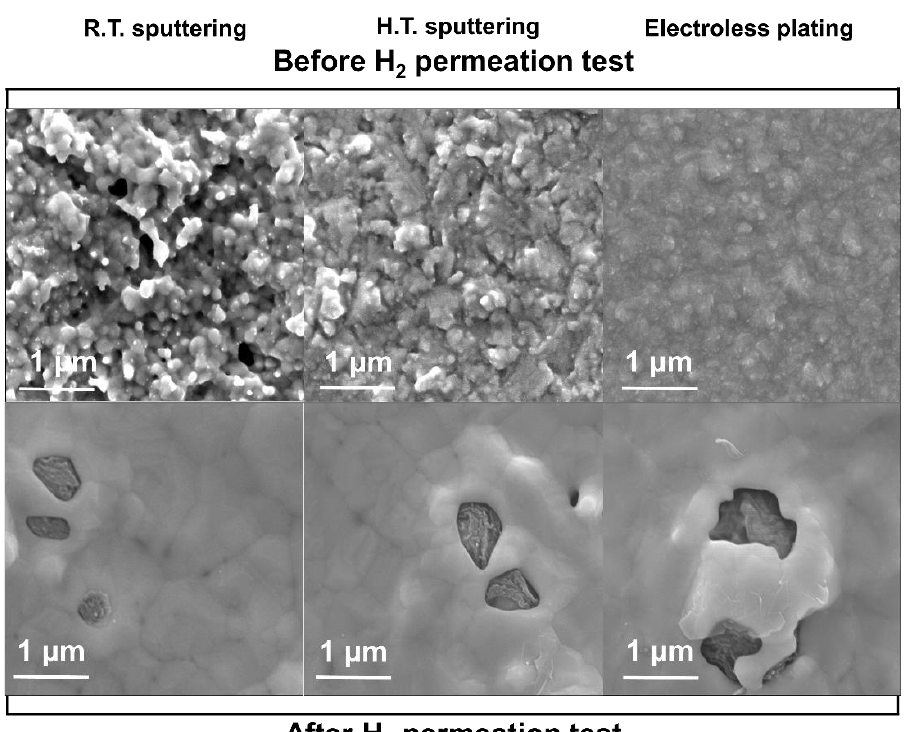
Figure 3. SEM surface micrographs (50,000 magnification) of the Pd/Ta membrane prepared by sputtering (SPT) at room temperature (R.T.) and high temperature (H.T.: 400 °C), and electroless plating (ELP), before and after the H 2 permeation test at 500 °C.